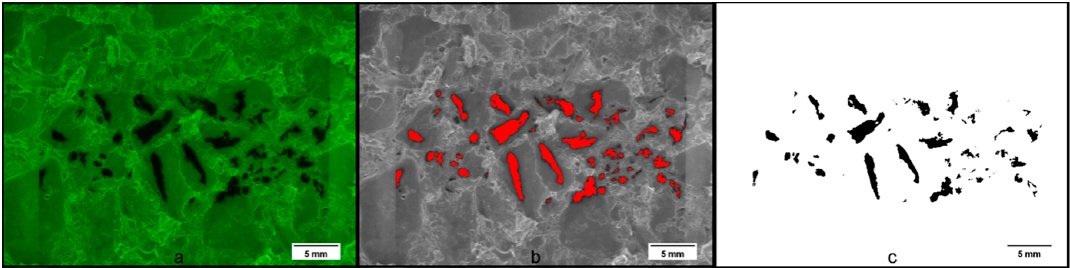
Figure 6. Rubber-wheel contact on the flat surface of urethane material under normal load 50 N, ( a ) original image; ( b ) binary image based on Otsu thresholding.